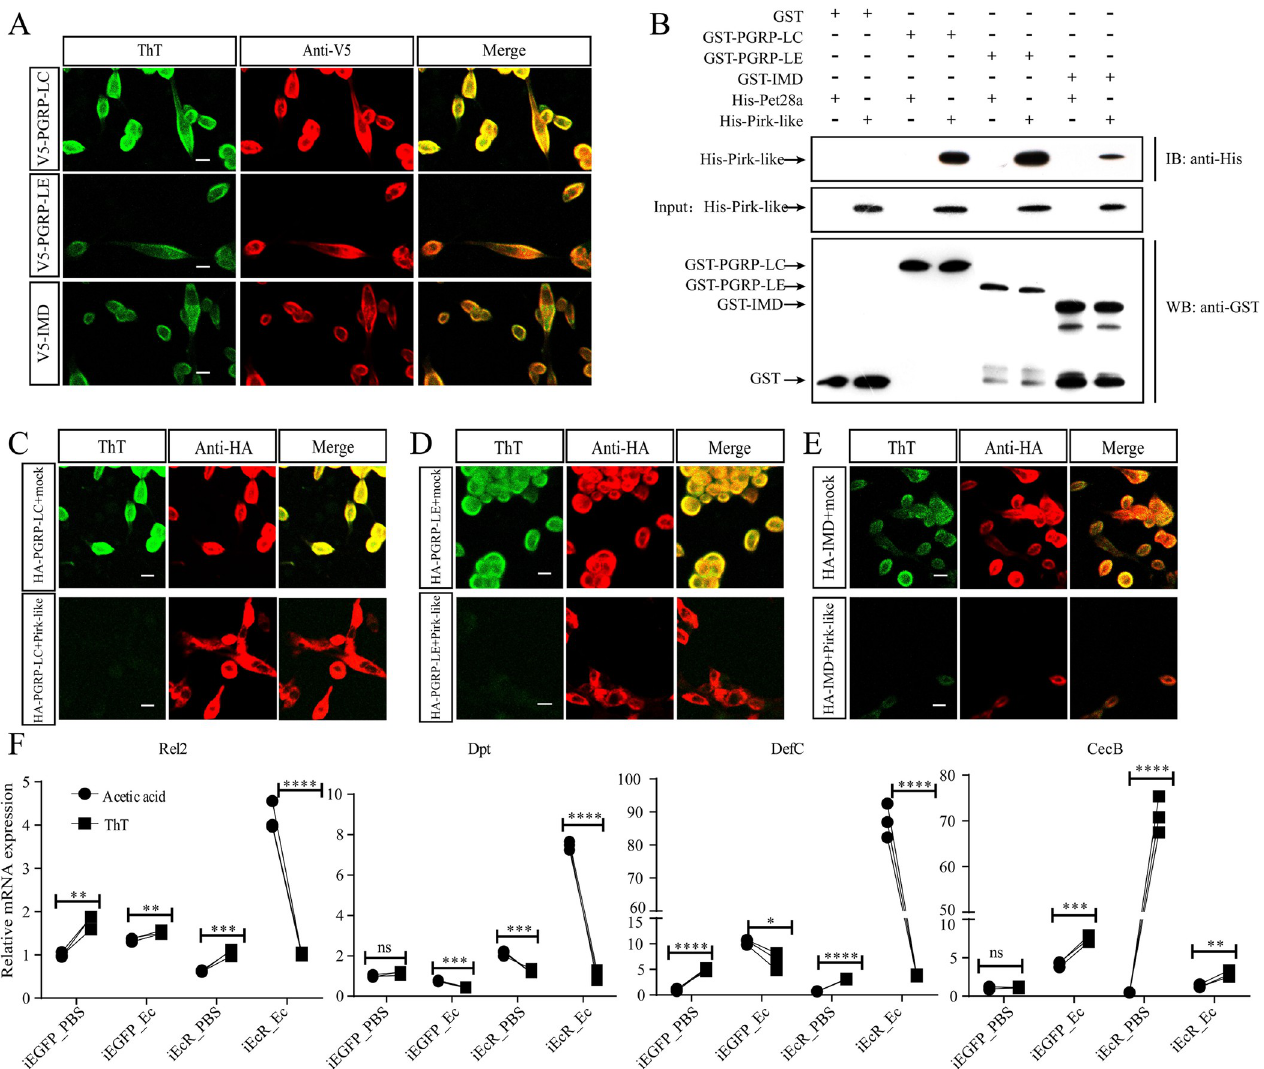
Fig 5. Pirk-like interferes with amyloidal aggregates formed by PGRP-LC, PGRP-LE, and IMD. (A) Amyloidal aggregate staining of Aag2 cells transiently transfected with V5-tagged PGRP-LC, PGRP-LE or IMD. Scale bar: 10 μ m. (B) GST pull-down assay between PGRP-LC, PGRP-LE, IMD, and Pirk-like. The interactions of His-Pirk-like with GST-PGRP-LC, GST-PGRP-LE or GST-IMD were observed in the pull-down assay and confirmed using western blots with anti-GST and anti-His antibodies. (C-E) ThT fluorescence in Aag2 cells co-expressed with Ha-tagged PGRP-LC (C), PGRP-LE (D) or IMD (E), and either an empty vector (mock) or a V5-Pirk-like. Scale bar: 10 μ m. (F) Expression of Rel2 , Dpt , DefC and CecB in iEGFP and iEcR mosquitoes infected with E . cloacae in the presence of ThT. Acetic acid was used as control. Data are shown as mean ± SEM. ���� p < 0.0001; ns, not significant (one-way ANOVA followed by Bartlett’s